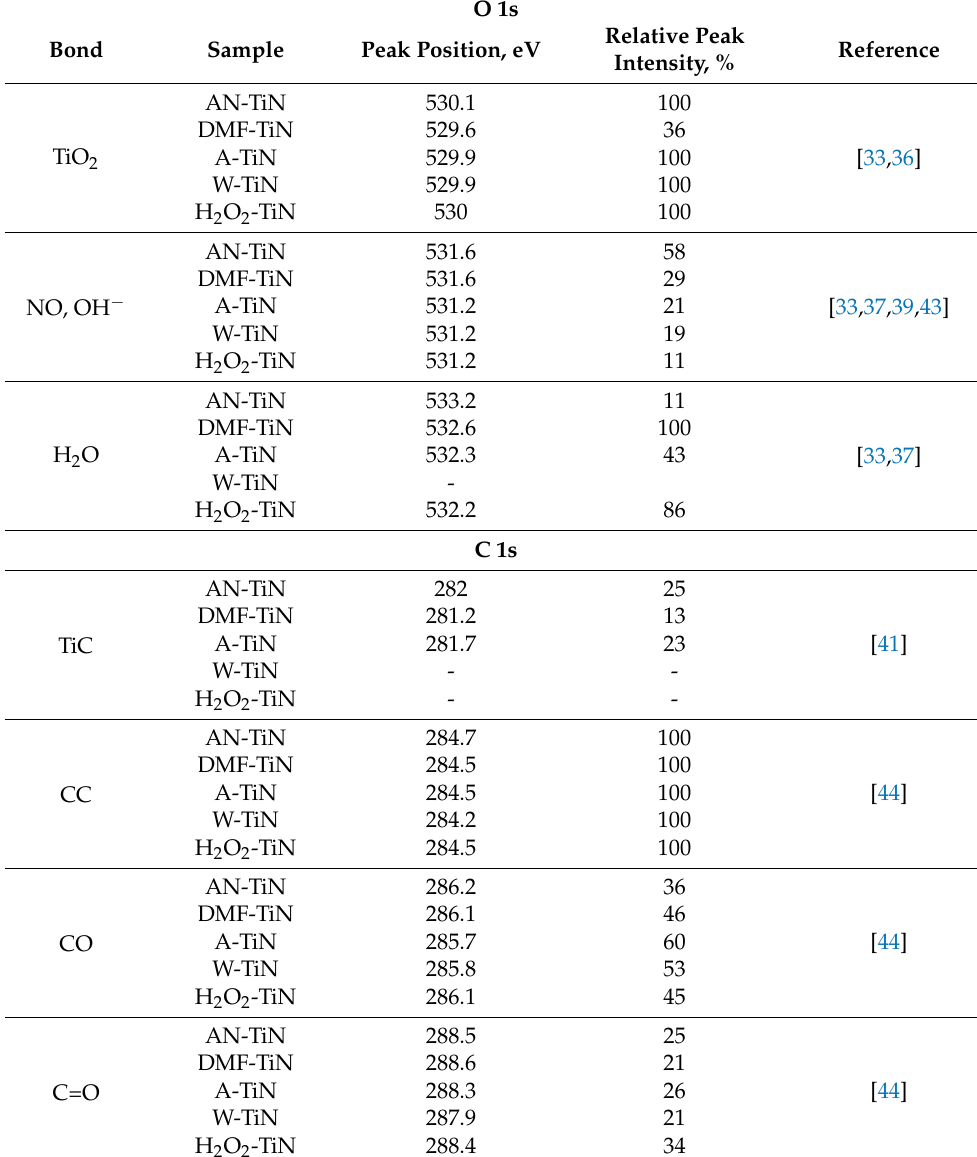
Table 2. Results of deconvolution of O 1s and C 1s XPS spectra of the synthesized NPs. O 1s Relative Peak Reference Bond Sample Peak Position, eV Intensity, % AN-TiN 530.1 TiO 2